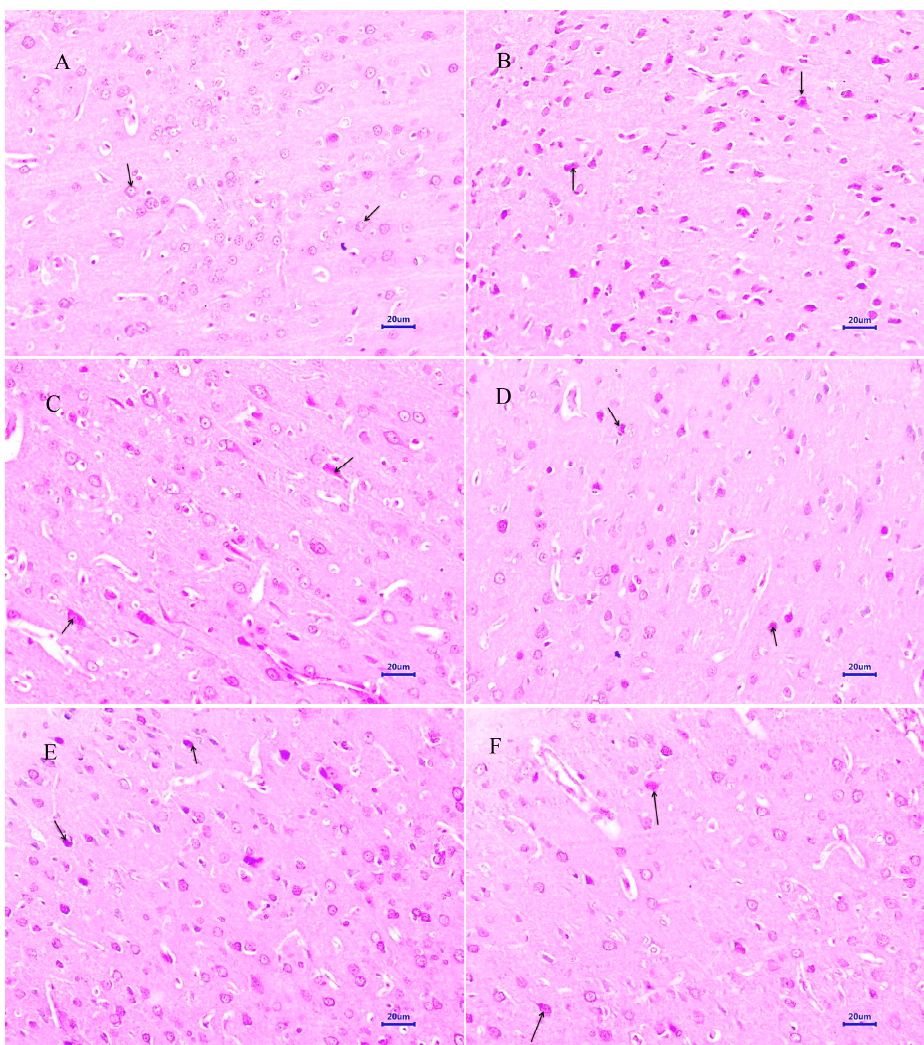
Figure 7. Effect of A β (1–42), baicalein and baicalein with memantine on H&E-stained cortex tissue (400×). ( A ) Normal control: displaying normal histology, normal neuronal cells in parietal cortex (arrow). ( B ) Disease control: displaying multifocal reduced layer of neuronal cells and sever neurodegeneration with pyknotic nuclei in cortex (arrow). ( C ) Memantine 20 mg/kg: displaying moderate neurodegeneration with pyknotic nuclei in cortex (arrow). ( D ) Baicalein (10 mg/kg): displaying multifocal mild to moderate neuronal degeneration with pyknotic nuclei in cortex (arrow). ( E ) Memantine + Baicalein (20 + 5 mg/kg): displaying multifocal minimal to mild neurodegeneration with pyknotic nuclei in cortex (arrow). ( F ) Memantine + Baicalein (20 + 10 mg/kg): displaying minimal neuronal degeneration in cortex (arrow).